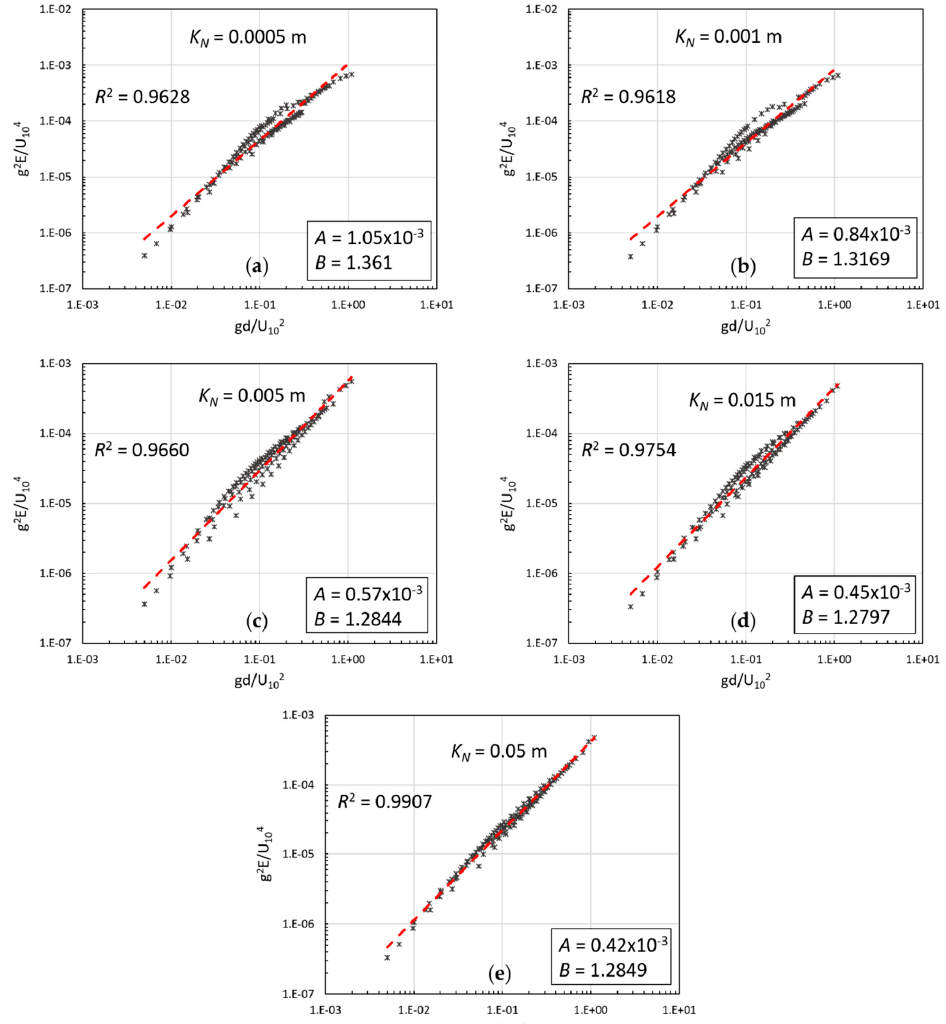
Figure 2. Dimensionless wave energy grouped by different bottom roughness values: ( a ) K N = 0.0005 m; ( b ) K N = 0.0001 m; ( c ) K N = 0.005 m; ( d ) K N = 0.015 m; ( e ) K N = 0.05 m. Red dashed lines are regression curves obtained by means of the least squares method. Correlation coefficients R 2 of each linear regression are indicated on each plot. The relative coefficients A and B entering in Equation (4) are shown in the boxes.